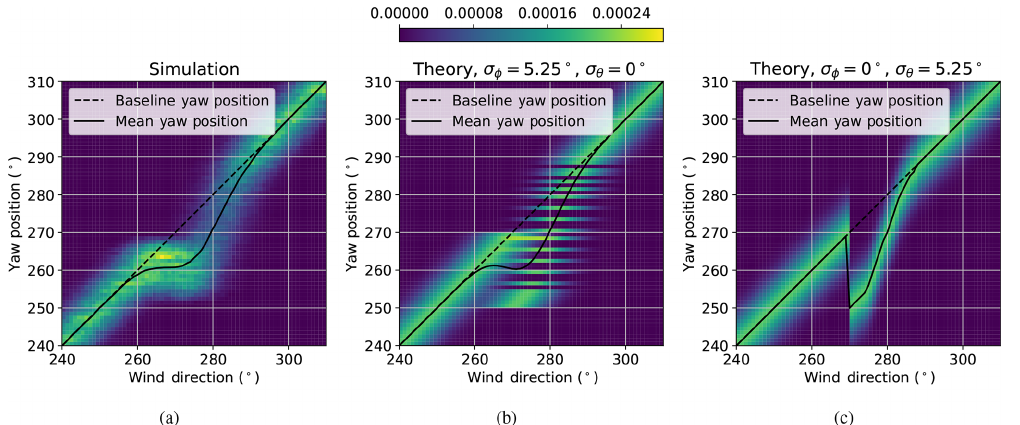
Figure 7. Distributions of low-frequency wind direction and yaw position with yaw offset control using a static-optimal yaw offset schedule: (a) histogram from simulation results and theoretical probability density functions assuming (b) only wind direction uncertainty and (c) only yaw position